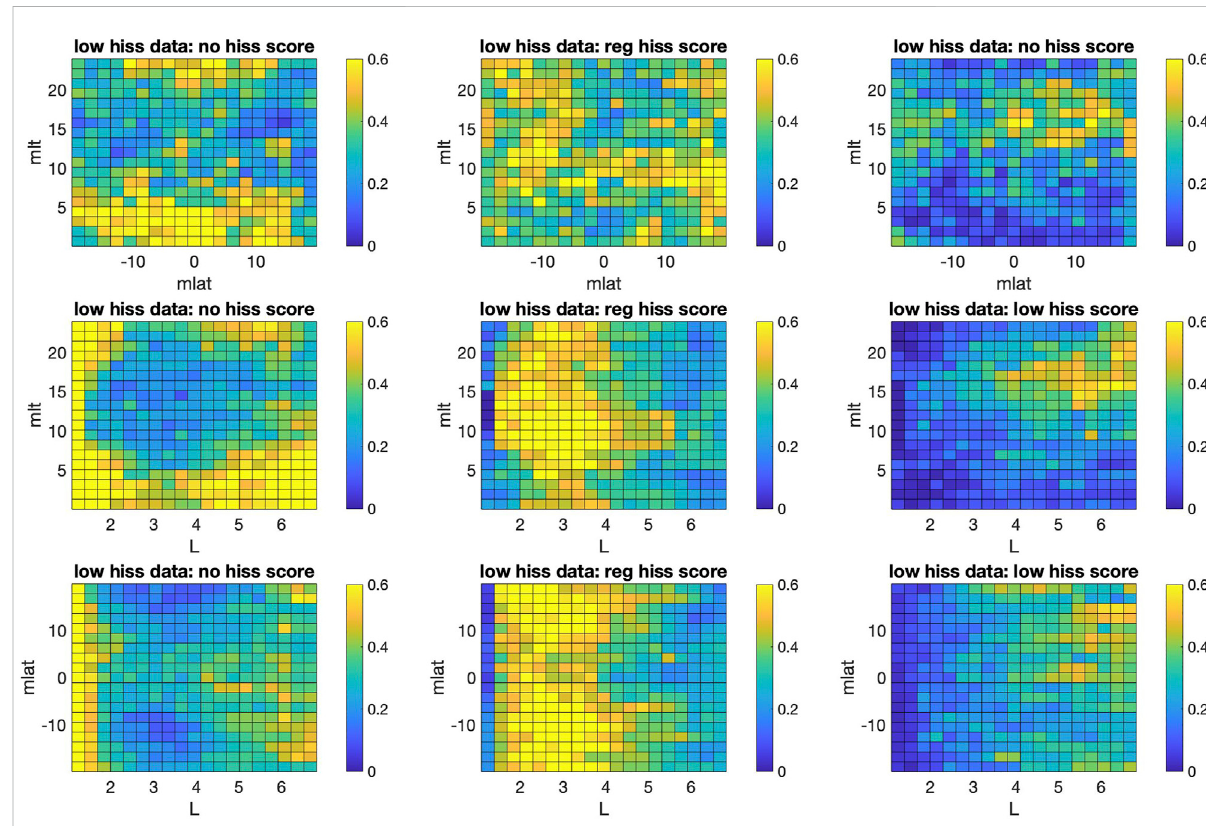
FIGURE 5 Partial dependence (Eq. 2) computed on “ low-frequency hiss ” data points; color bar corresponds to the score of RF